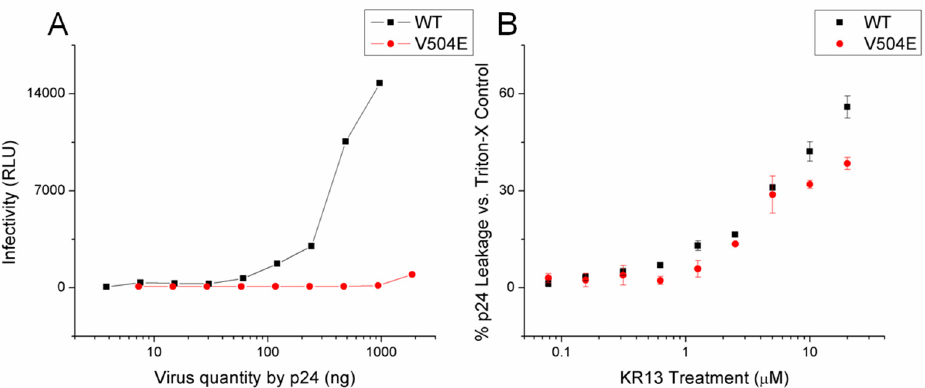
Figure 4. V504E JRFL fusion peptide nullification mutant pseudovirus loses infectivity but retains susceptibility to KR13. ( A ) Infectivity of produced pseudovirus. ( B ) Lytic response to KR13 treatment (2 h incubation, 500 ng p24 virus quantity). Data shown are the average of three independent experiments, and error bars represent the standard deviation of the